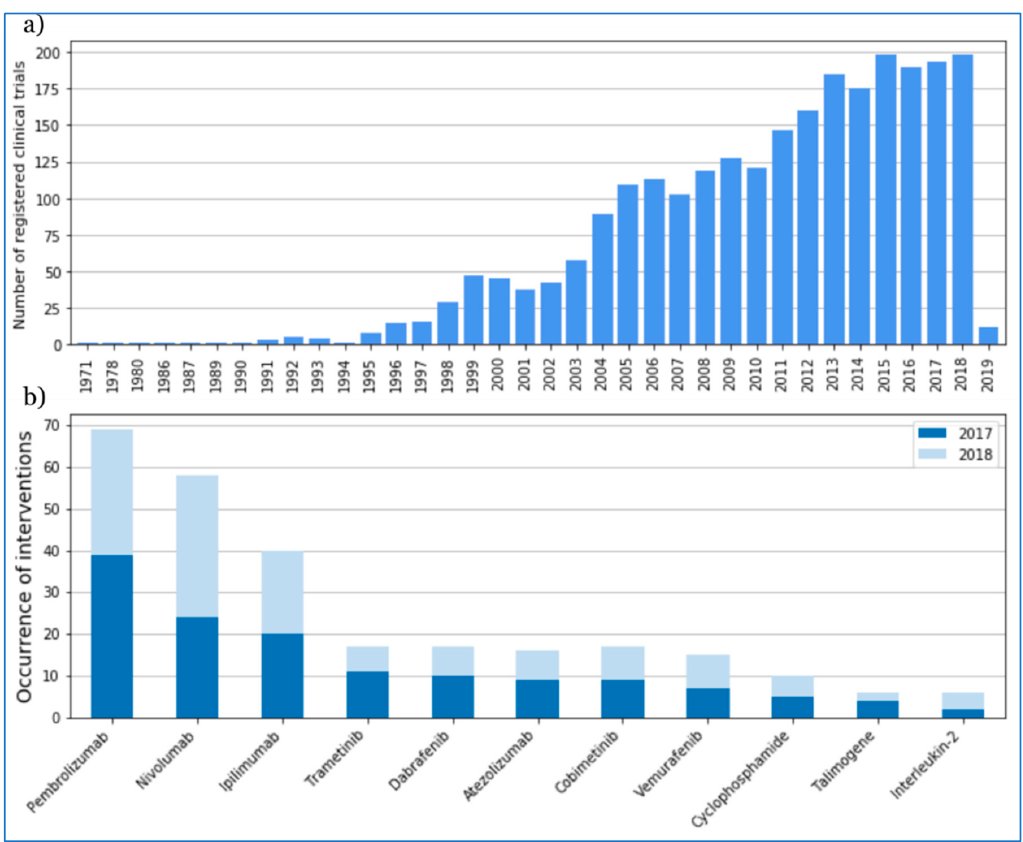
Figure 4. Number of trials starting each year from 1971 to 2019 based on International Clinical Trials Registry Platform (ICTRP) data ( a ). Most frequently mentioned melanoma interventions in the ICTRP database in 2017 and 2018 ( b ). J. Clin. Med. 2019 , 8 , x FOR PEER REVIEW